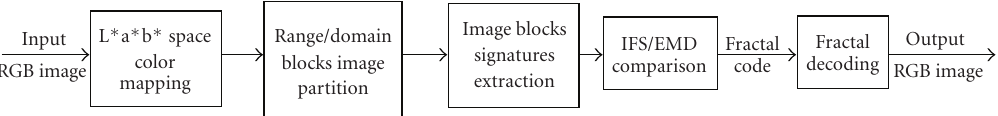
Figure 1: Fractal coding of colour images.